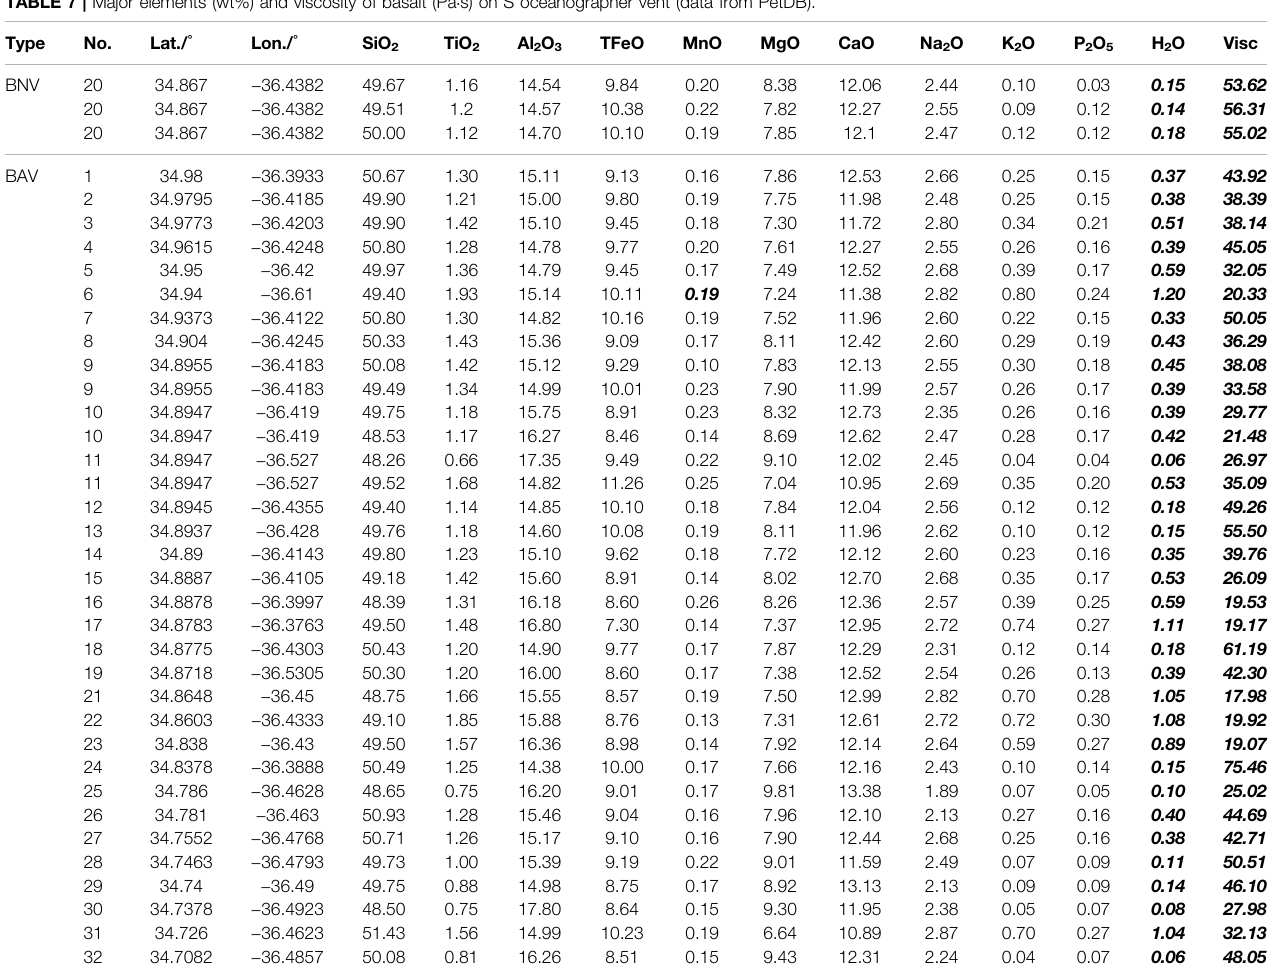
TABLE 7 | Major elements (wt%) and viscosity of basalt (Pa · s) on S oceanographer vent (data from PetDB). Type